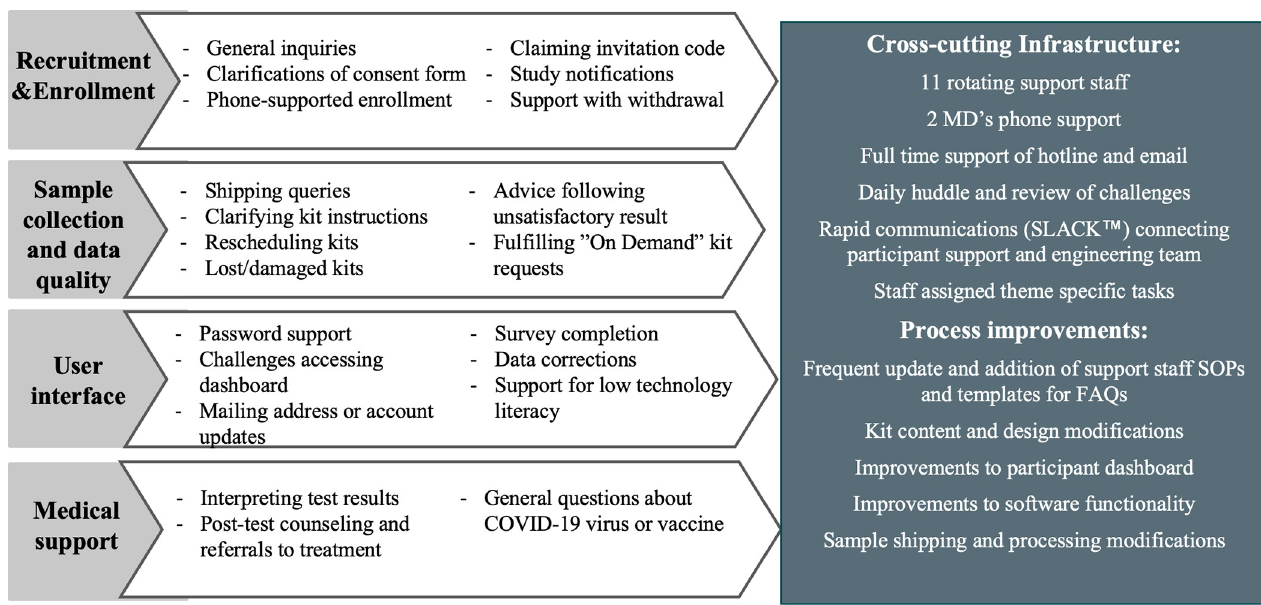
Fig 4. Participant support needs & cross-cutting infrastructure. Participant support needs (shown on the four left panels) fell into the following key domains: 1) Recruitment and enrollment, 2) sample collection and data quality, 3) user interface, and 4) medical support. As these needs emerged, the study team adopted numerous strategies to improve the participant experience and streamline operations (right